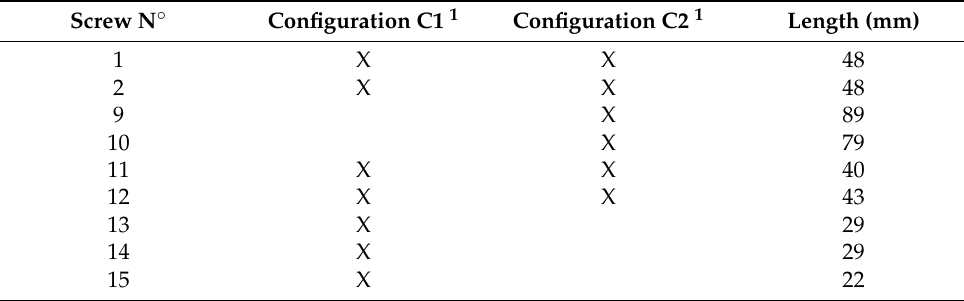
Table 1. Length of the screws (in mm) selected for the C1 and C2 configurations.